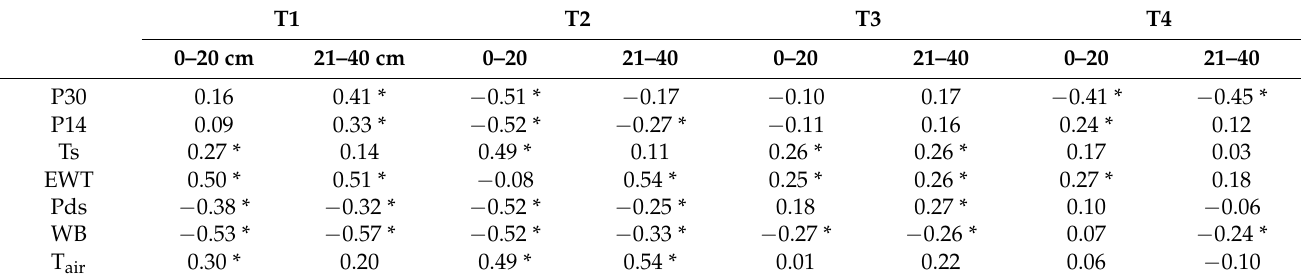
* Significant levels p < 0.05. Explanations: P30—rainfall 30 days before sampling; P14—rainfall 14 days before sampling; Ts—soil temperature; EWT—evapotranspiration; Pds—precipitation on the day of harvest; WB—water balance; T air —air